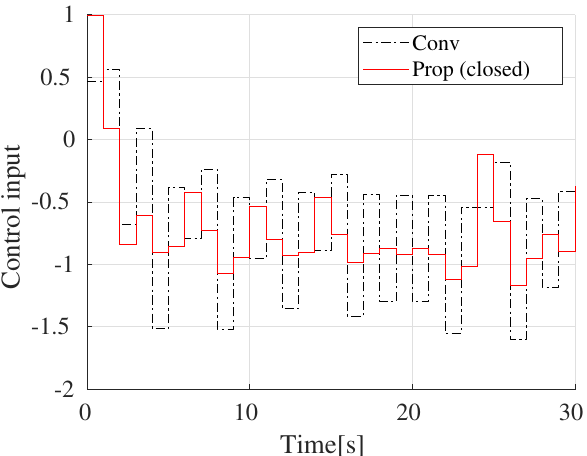
Figure 12. Input trajectories for unstable plant in the presence of